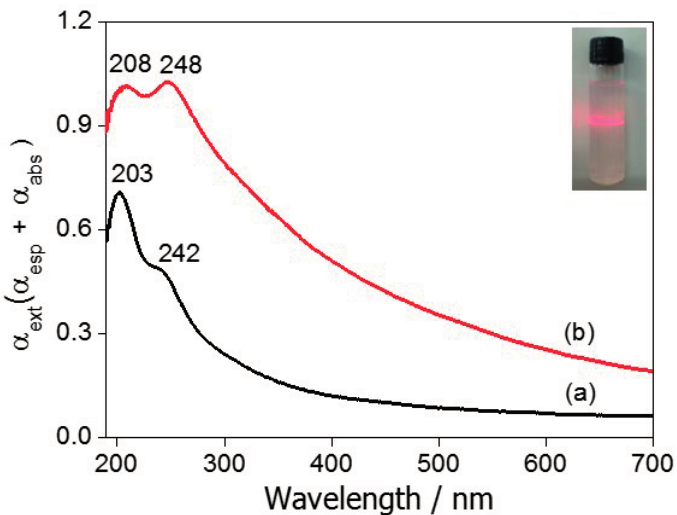
Figure 2. Electronic spectra in the UV-vis region for colloidal suspensions of (a) PBA and (b) PBA-CD. Inset: Tyndall effect for Co 3 [Co(CN) 6 ] 2 -CD.